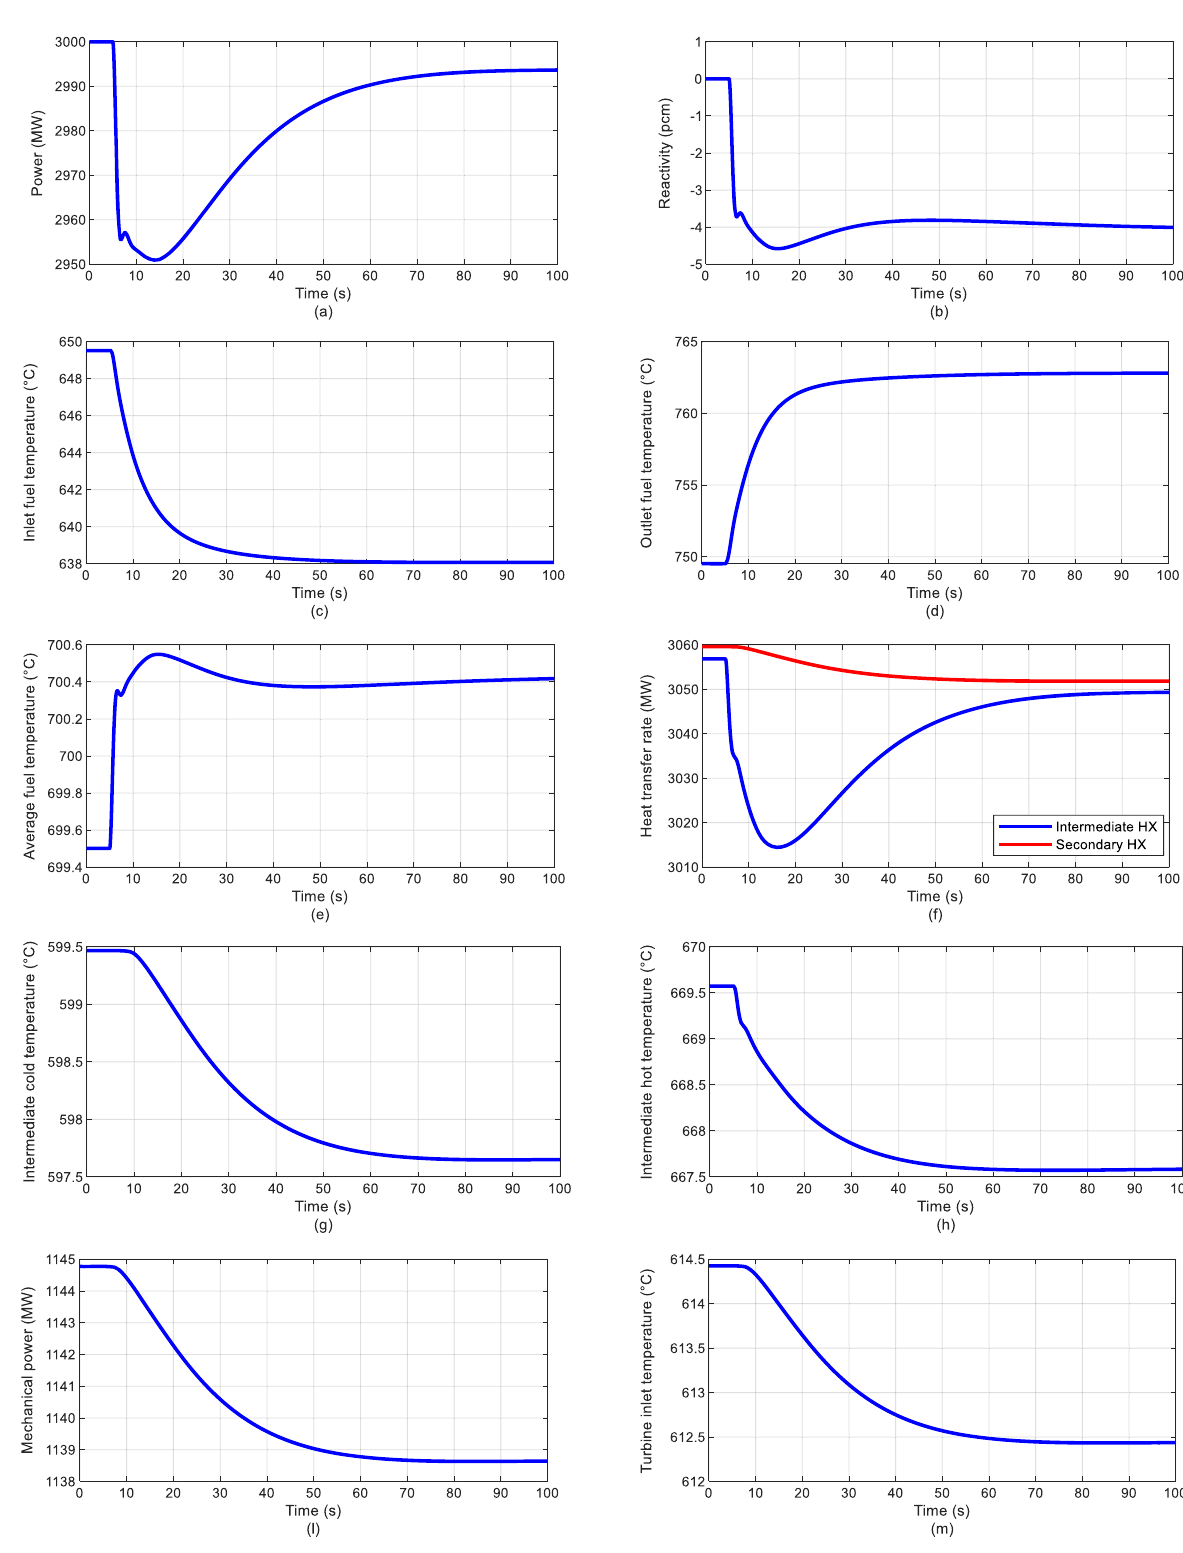
Fig. 13. Controlled variables evolution for 20% decrease of the fuel salt mass fl ow rate: (a) reactor thermal power; (b) net reactivity variation; (c) fuel inlet temperature; (d) fuel outlet temperature; (e) fuel average temperature; (f) heat transfer rates in the heat exchangers; (g) intermediate salt minimum temperature; (h) intermediate salt maximum temperature; (i) turbine mechanical power; (m) helium turbine inlet